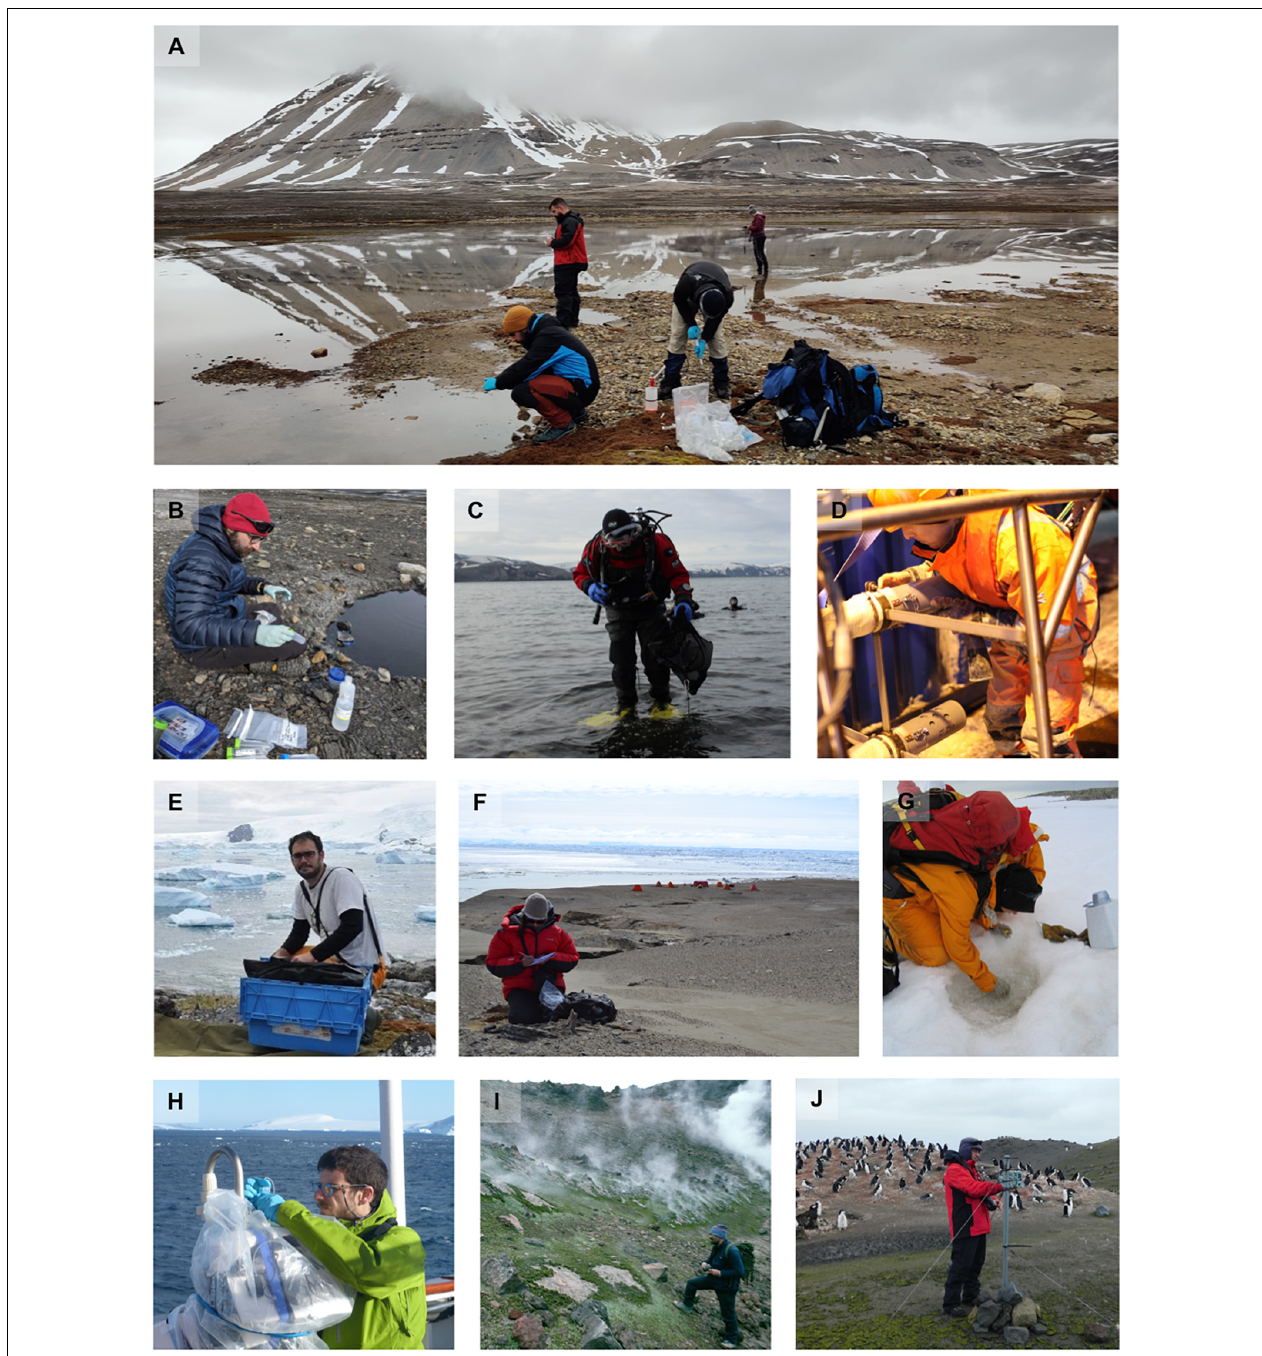
FIGURE 1 | Examples of activities by polar EMCRs and senior researchers in the Arctic and the Antarctic: (A) Monitoring eDNA and greenhouse gases in Bayelva catchment, near Ny-Alesund, Svalbard; (B) Sampling microbial mats from Gypsum Hill (Axel Heiberg Island, Nunavut, Canada), a unique sulfur-rich, cold spring system analog to Early Mars environments; (C) Sampling by scuba diving at –1 ◦ C to assess the composition and structure of benthic communities in the caldera of Deception Island, Antarctica; (D) Assembling an epibenthic sledge for deployment in the Weddell sea; (E) Internationally coordinated eradication act of an alien grass species in Cierva Point, Antarctica; (F) Collecting fossil bivalves from 45 million years old rocks in Seymour Island to study paleoenvironment and past climate changes; (G) Collecting microalgae samples from small meltwater areas to assess their diversity and distribution along latitudinal gradient at Casey Station, Antarctica; (H) Sampling of air microorganisms to understand microbial dispersal patterns in the polar atmosphere; (I) Examining vegetation zonation around areas of intense geothermal heating on Bellingshausen Island, South Sandwich Islands, in a study combining bryophyte ecophysiology and biogeography; (J) Download of penguin breeding pictures taken by automatic-cameras to monitor phenology, breeding success and population changes in chinstrap penguin of Deception Island, Antarctica. Credits: A. Popp, B. O’Connor, E. Ballesté, I. Peeken, P. Escribano, F. Podestá, R. A. Rahim, A. Justel, P. Bucktrout, A.L. Machado.